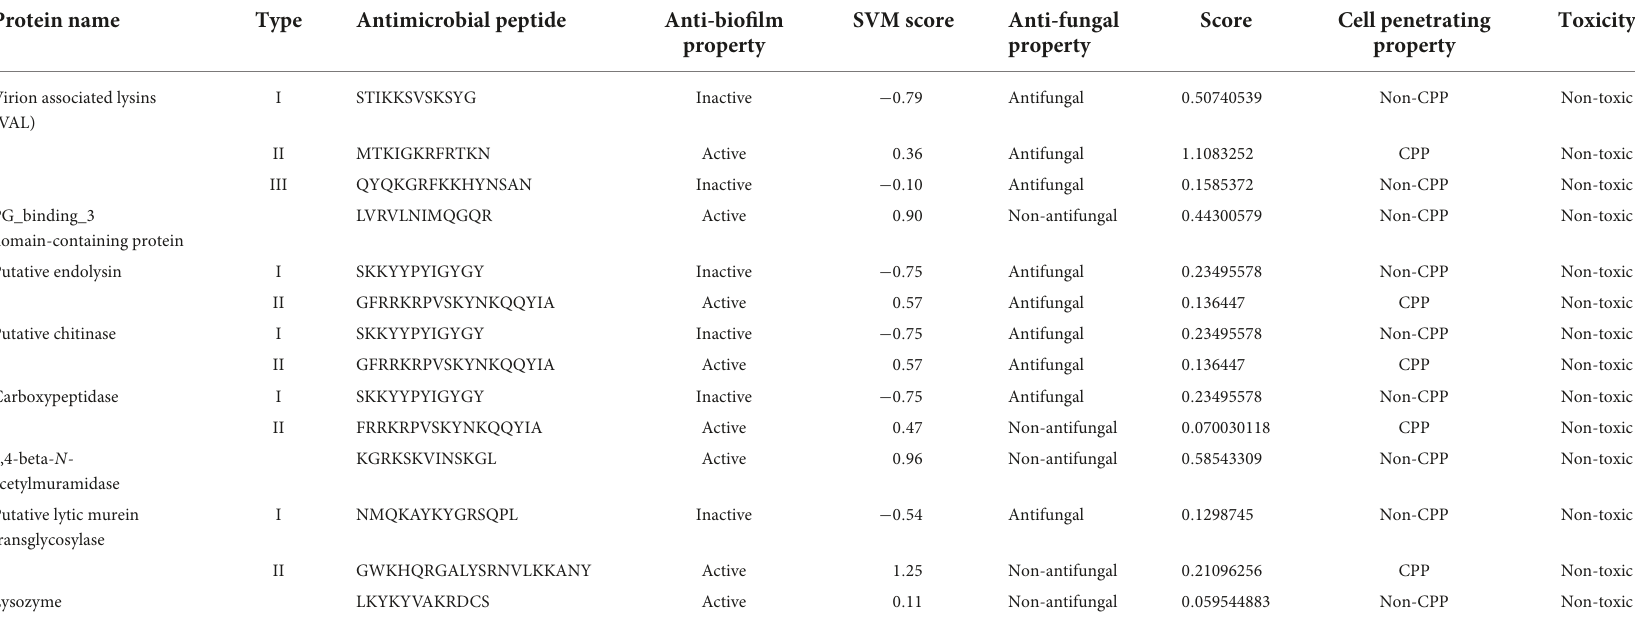
TABLE 3 Predicted antimicrobial peptides and their anti-biofilm and anti-fungal